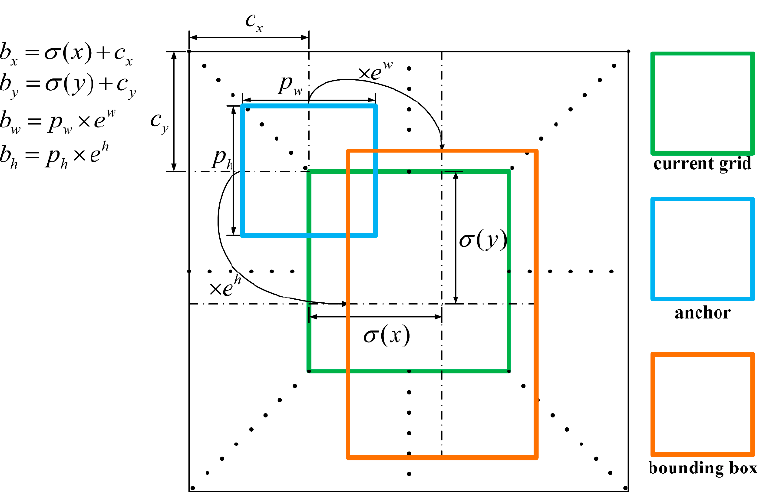
Figure 9. The process of converting anchor to bounding